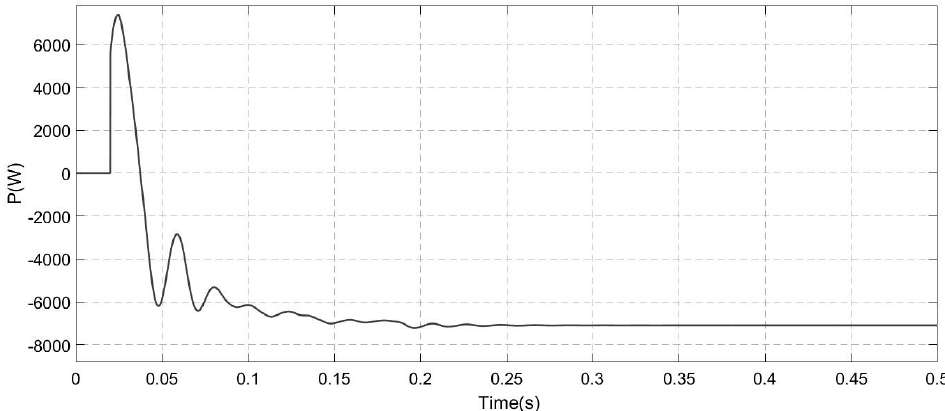
Figure 7. Waveform of active power in PCC.